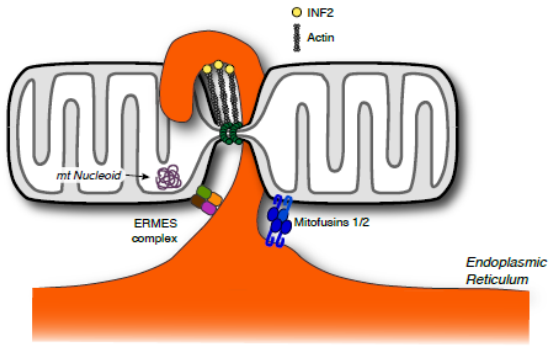
Figure 3. Mitochondrial interactions with the endoplasmic reticulum mark sites of ensuing fission. This connection is mediated by different protein tethering complexes, including mitofusin heteropolymers and the endoplasmic reticulum-mitochondria encounter structure (ERMES) complex. Proteins on the endoplasmic reticulum (ER) membrane serve as nucleation sites for building actin filaments that also constrict mitochondria and may provide tension needed during the membrane scission event. INF2: Inverted formin